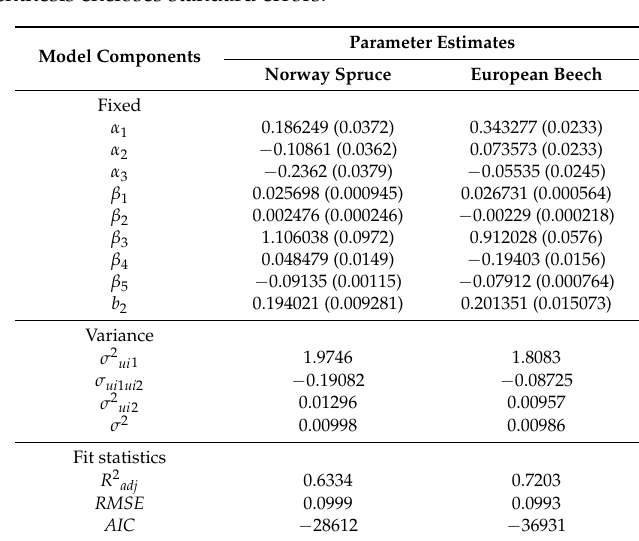
Table 2. Estimated values of parameters, variance components, and fit statistics of the generalized mixed-effects CR model (Equation (2)). R 2 adj : adjusted coefficient determination; RMSE : root mean square errors; AIC : Akaike’s information criterion; α 1 , α 2 , α 3 , β 1 , . . . , β 5 , b 2 : fixed parameters; u i 1